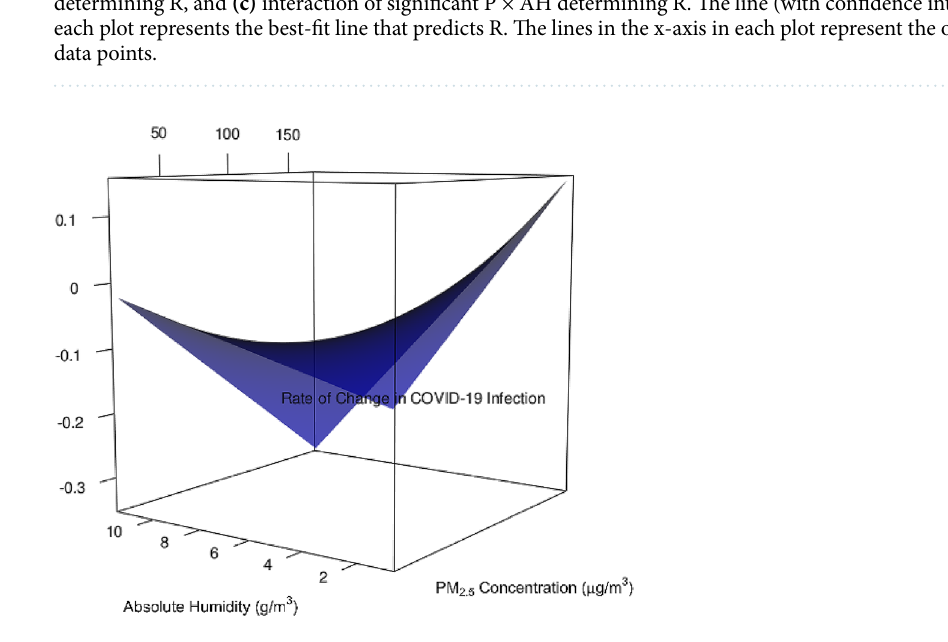
Figure 3. Relationship between P, AH, and R, based on the observed range of P and AH and the predicted R from the best-fit regression model, for 18 high infection provincial capital cities in